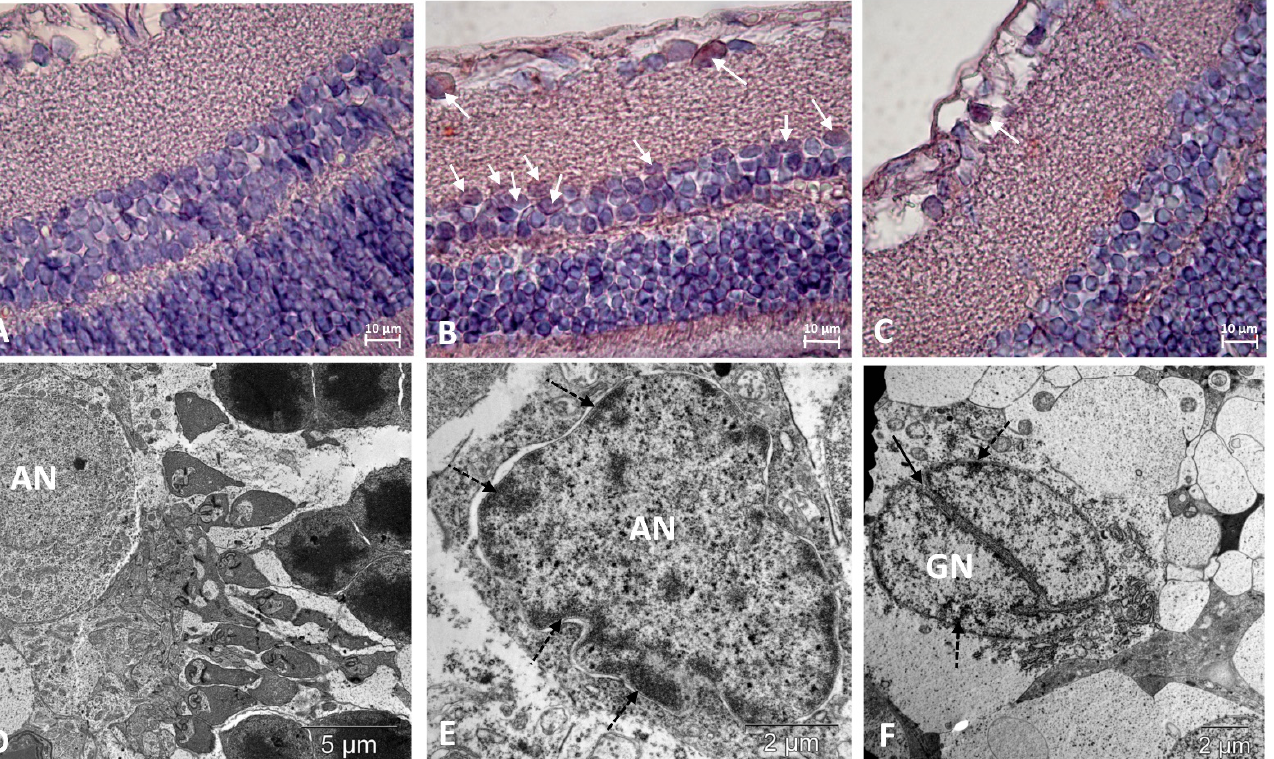
Figure 3. Immunostaining did not reveal p53-positive cells in the retinas of Wistar rats ( A ) and revealed them among neurons in the ganglionic and inner nuclear layers of the retina of OXYS rats (white arrows) ( B ). Treatment with IQ-1S significantly decreased the number of p53-positive cells in the retinas of OXYS rats ( C ). The electron micrographs show ultrastructural features of the normal structure of an associative neuron (AN) in Wistar rats ( D ) and examples of morphological manifestations of apoptosis in retinal neurons of OXYS rats: ( E ) nuclear invagination and marginal chromatin condensation (dashed arrows) in the associative neuron; ( F ) division of the nucleus of the ganglionic neuron (GN), marginal condensation of chromatin in the nucleus (dashed